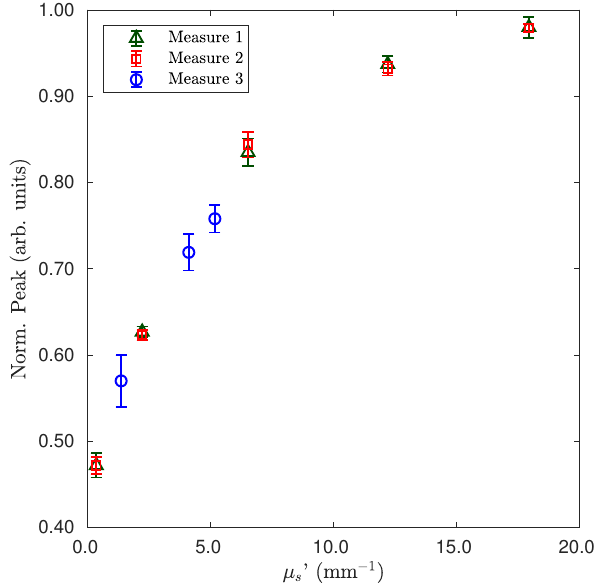
Figure 4. Test of reproducibility by measurements performed at different times and with two different sets of dilutions of Intralipid (one set for Measures 1 and 2 and the second one for Measure